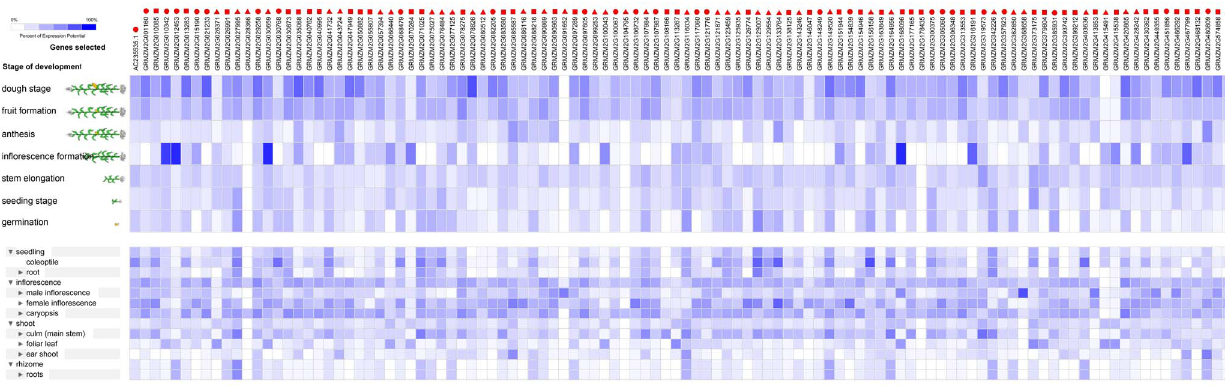
Figure 6. The expression profiles of 54 RNA helicase genes in Zeamays . The expression profiles of 54 RNA helicase genes in different development stages (above) and different tissues (below) in Zea mays . The deep and light blue shading represents the relative high or low percent potential expression levels, respectively, of the helicase genes in different development stages and different tissues. The DEAD-box, DEAH-box and DExD/H-box RNA helicase genes are indicated by the red triangle, circle and square, respectively.